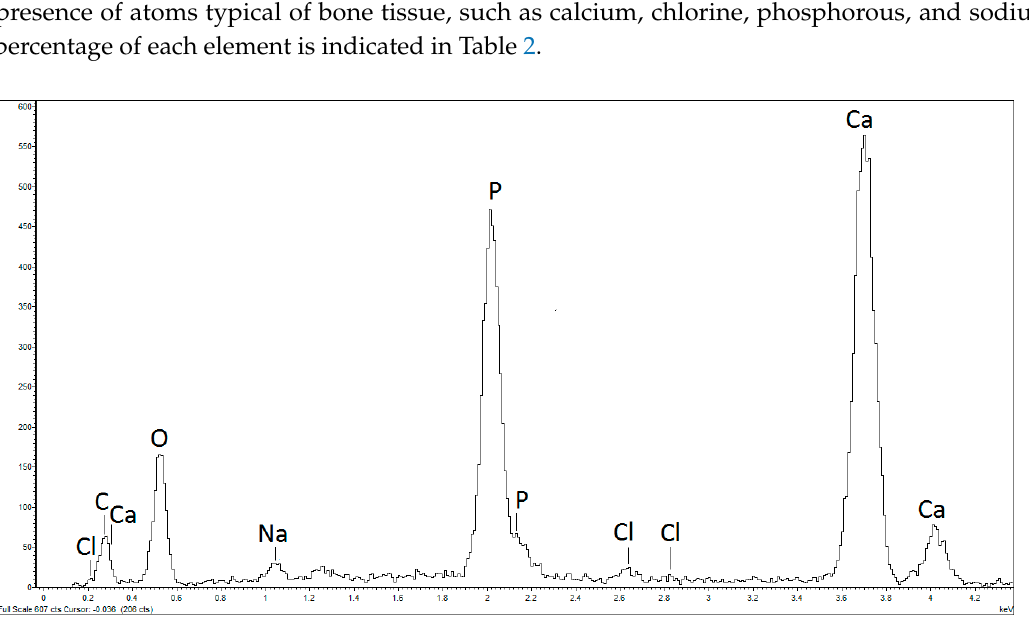
Figure 2. SEM X ‐ ray microprobe semi ‐ qualitative analysis. Ossicle’s surface presents the atoms O, C, Figure 2. SEM X-ray microprobe semi-qualitative analysis. Ossicle’s surface presents the atoms O, C, Cl, Na, P, and Ca characteristic of the bone tissue. Cl, Na, P, and Ca characteristic of the bone tissue. Table 2. Atoms present on the SO surface expressed in wt%. Table 2. Atoms present on the SO surface expressed in